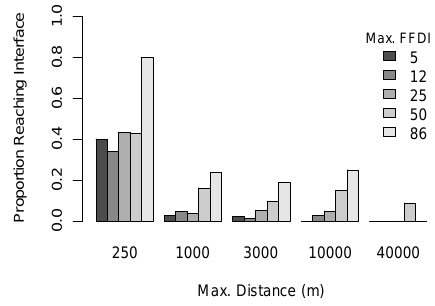
Fig. 3 Fig. 3. The proportion of fires that burnt the WUI buffer in different distance and FFDI